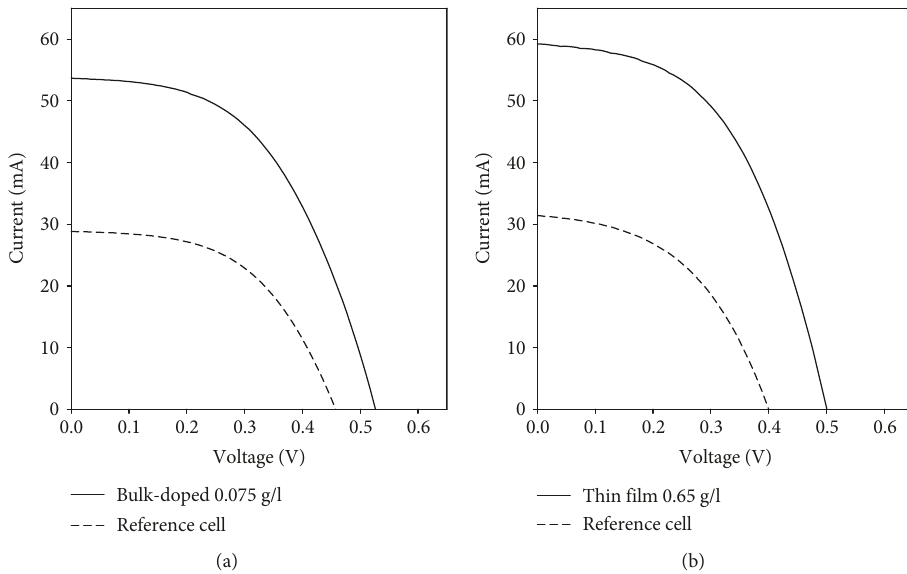
Figure 5: IV curves of optimized bulk-doped (a) and thin- fi lm (b) LSCs and reference cells. Open circuit voltages and short circuit current both experience gains with increased irradiance. The relatively low open circuit voltages of the naked reference cells may suggest that a relatively high fraction of incident light was obstructed by contacts and tabbing wire located on the cell surface. Table 1: Characteristics of optimized bulk-doped and thin- fi lm LSCs. Device